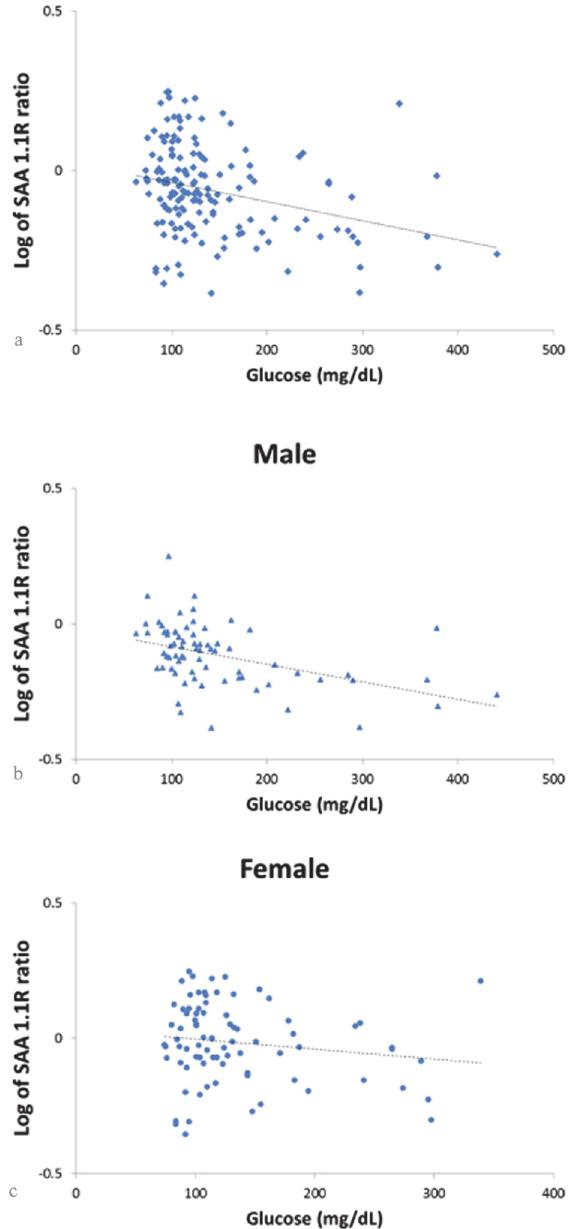
glucose levels (panel a, r = − 0.3, p < 0.001). This correlation was driven by the males in the study. The log of SAA 1.1R was inversely correlated to glucose in males (panel b, r= − 0.44, p < 0.001), but not in females (panel c, r = − 0.15, p =